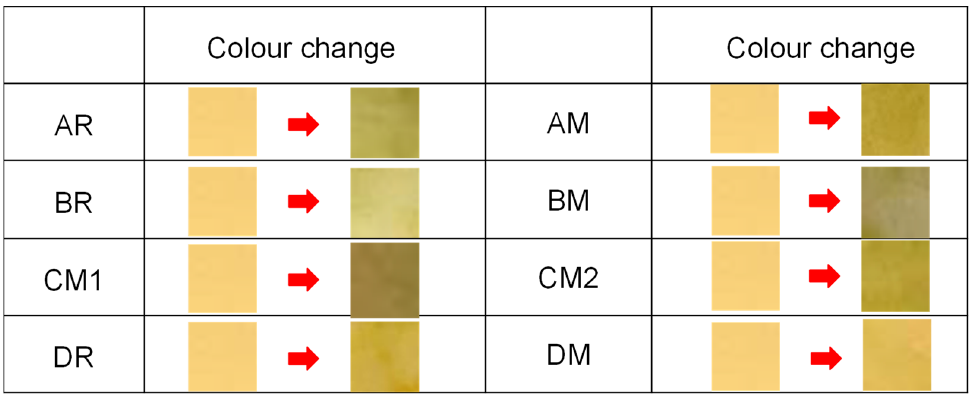
Figure 2. Colour changes in the universal pH indicator paper before and after exposure to 10 puffs of the mainstream aerosols generated from each heated tobacco product.